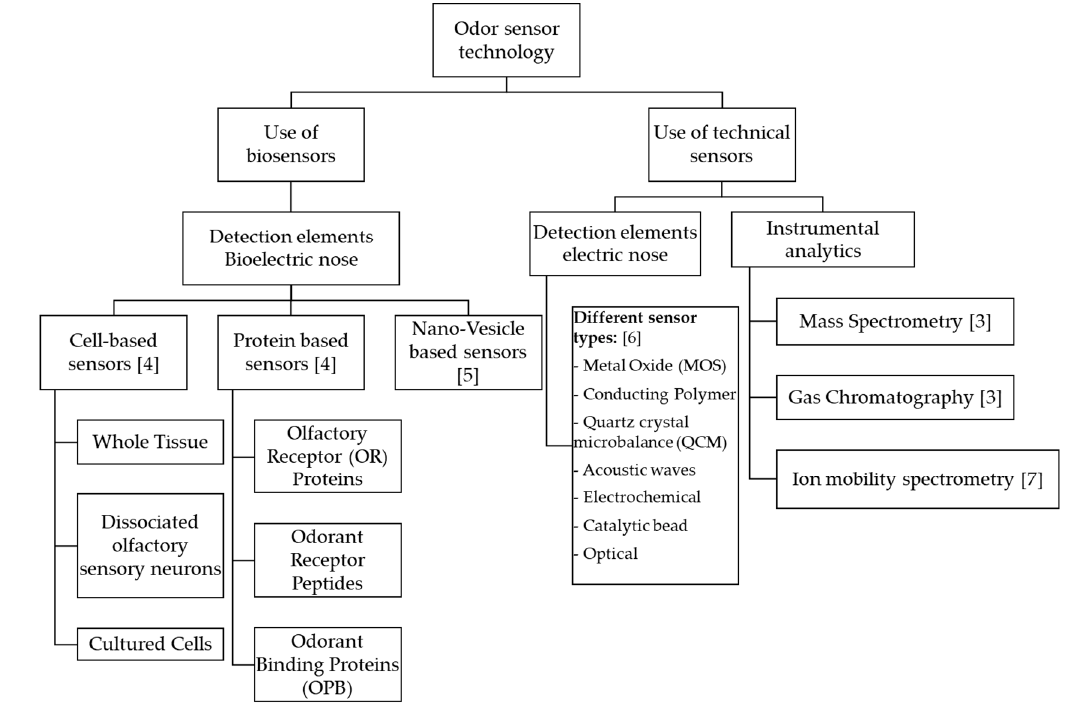
Figure 1. Overview of different technologies for odor detection. Own presentation, based on